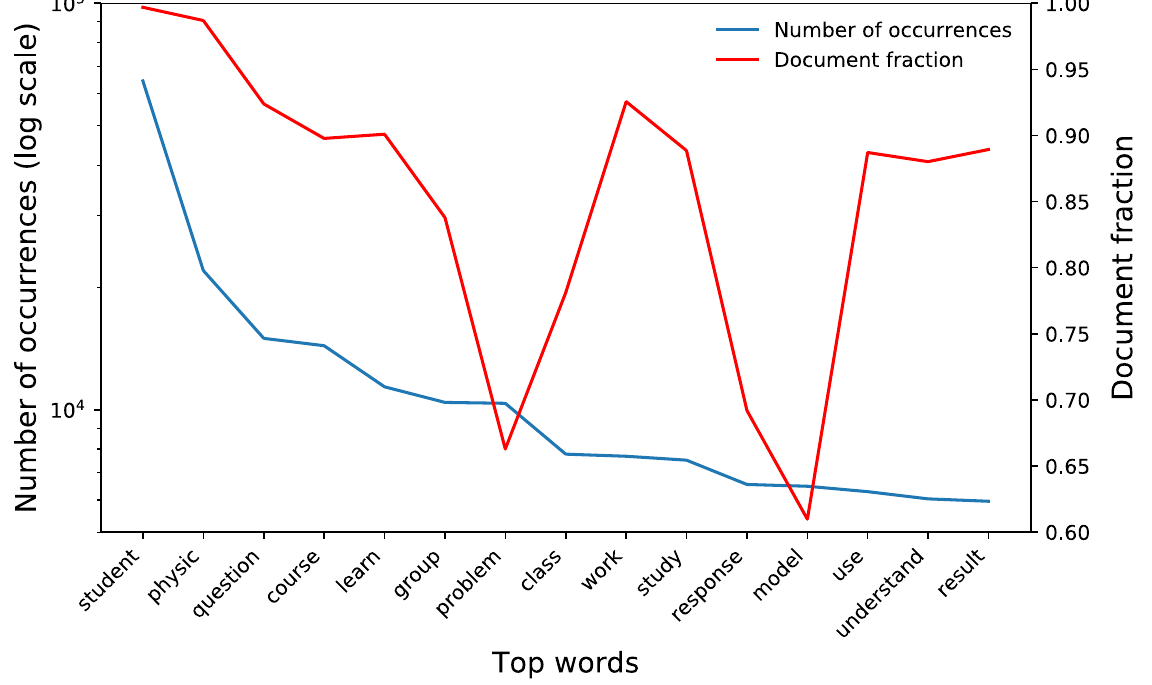
FIG. 4. Frequency of 20 most common words in the data corpus (29 026 words total). For each word, both the overall number of occurrences and the fraction of documents containing that word are